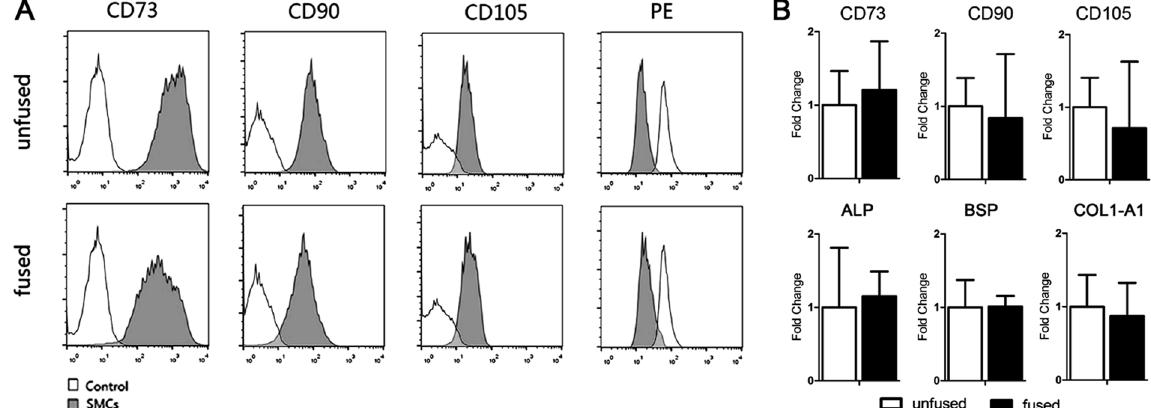
Figure 1. Characterization of the fused and unfused cranial SMCs. ( A ) Cell surface antigen phenotyping of human calvarial SMCs. Flow cytometric analysis showing the surface expression of CD90, CD105, and CD73, indicative of a mesenchymal immunophenotype, on both fused and unfused SMCs. PE: PE-labeled negative multipotent mesenchymal stromal cell (MSC) cocktail; control: negative control group. ( B ) Expression of the mesenchymal markers CD90, CD105, and CD73, as well as expression of the osteogenic markers ALP and BSP, and the chondrogenic marker COL1-A1 in fused and unfused SMCs, as determined by qPCR. Data are expressed as the mean ± SD of three independent